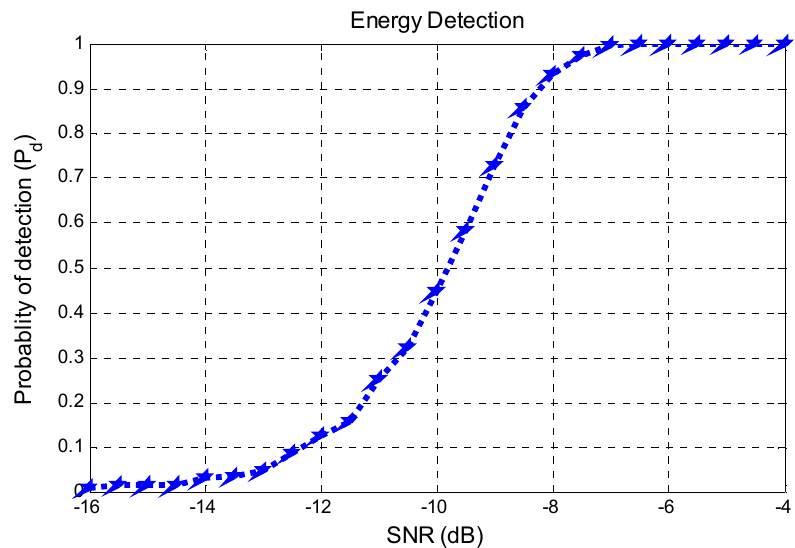
Figure 5. Distribution probability of PU detection over the signal to noise ratio.